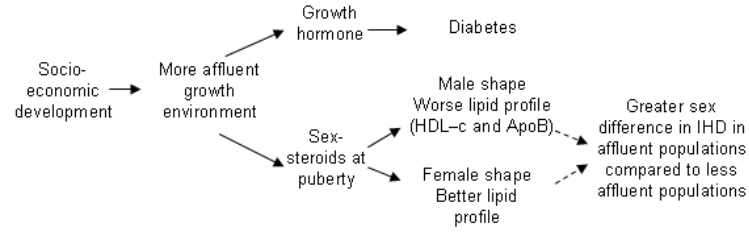
Figure 1. Hypothetical causal pathways.